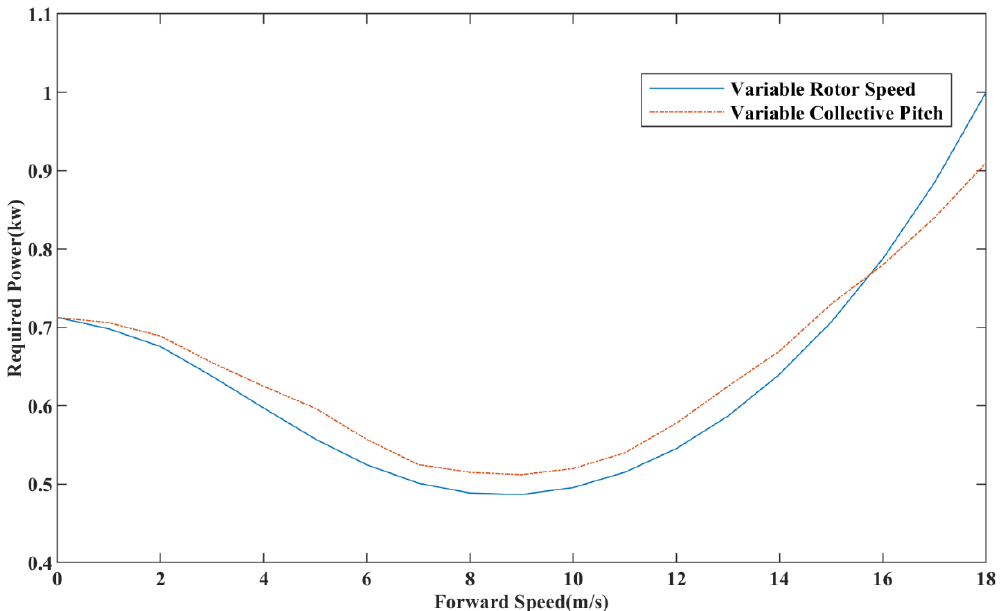
Figure 4. The variation in required power to the forward speed between variable rotor speed coaxial helicopter and variable collective-pitch coaxial helicopter.